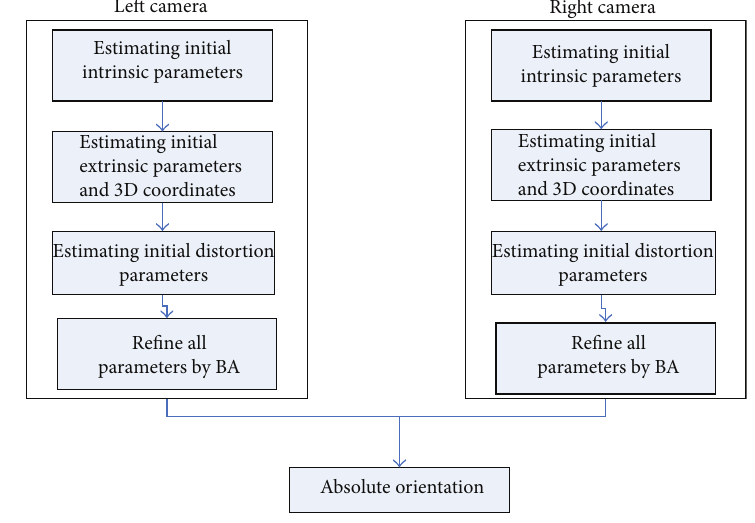
Figure 4: Algorithm